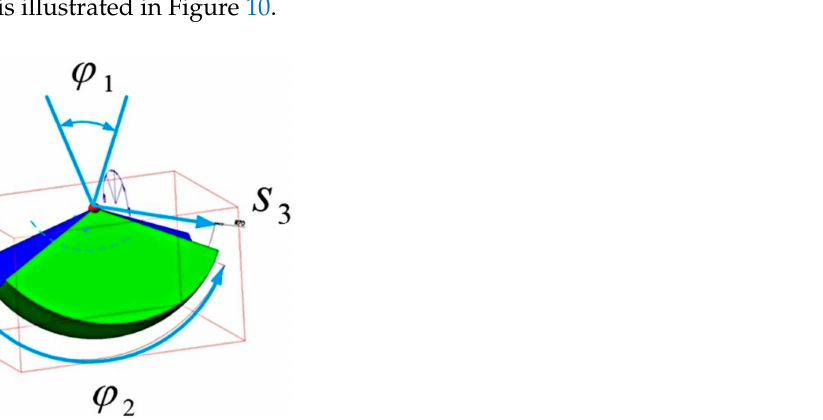
Figure 10. The spherical shape of the working space obtained by the remote center of motion mechanism of a surgical robot. The joints variables are: ϕ 1 , ϕ 2 , s 3